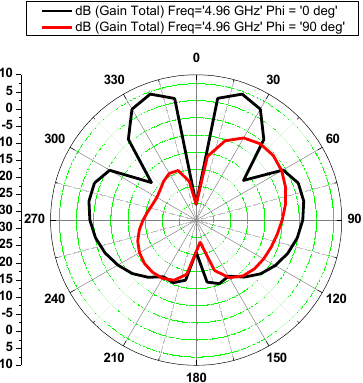
Figure 12:Radiation pattern of 2×2 MTPAA at 4.98 GHz